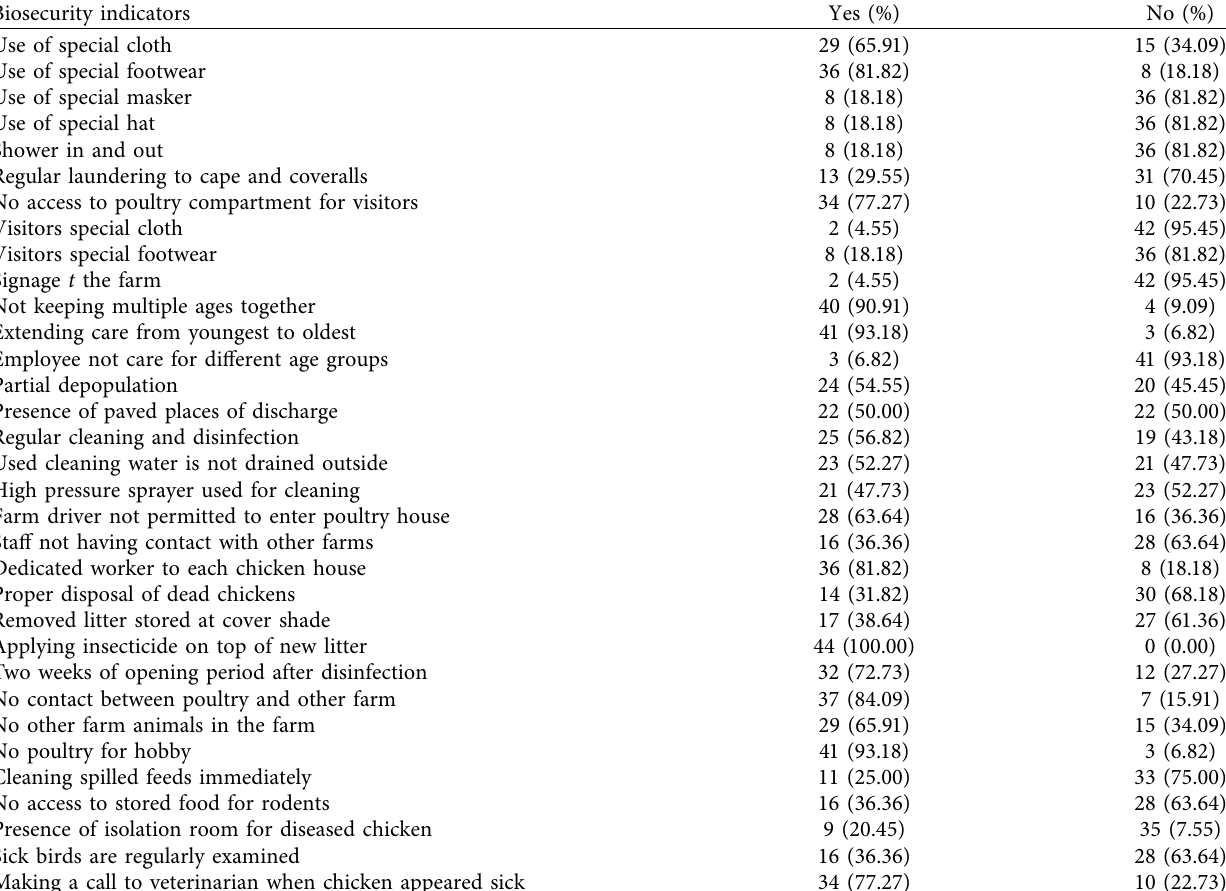
Table 5: The frequency and percentage of operational biosecurity